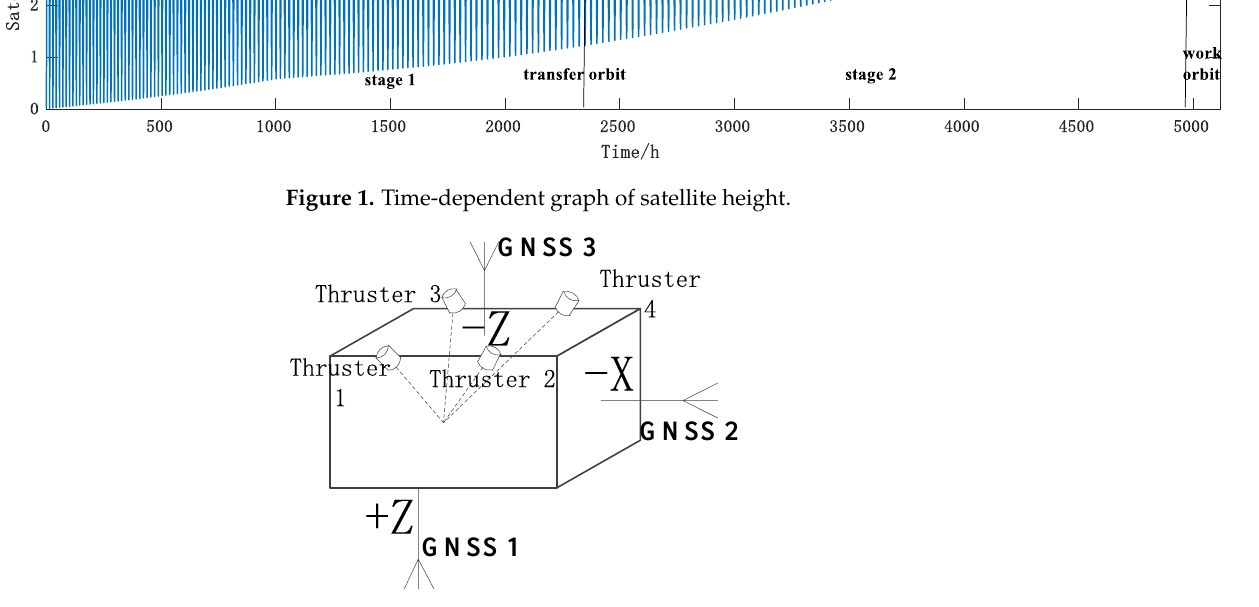
Figure 2. Installation diagram of thruster and GNSS antennas.